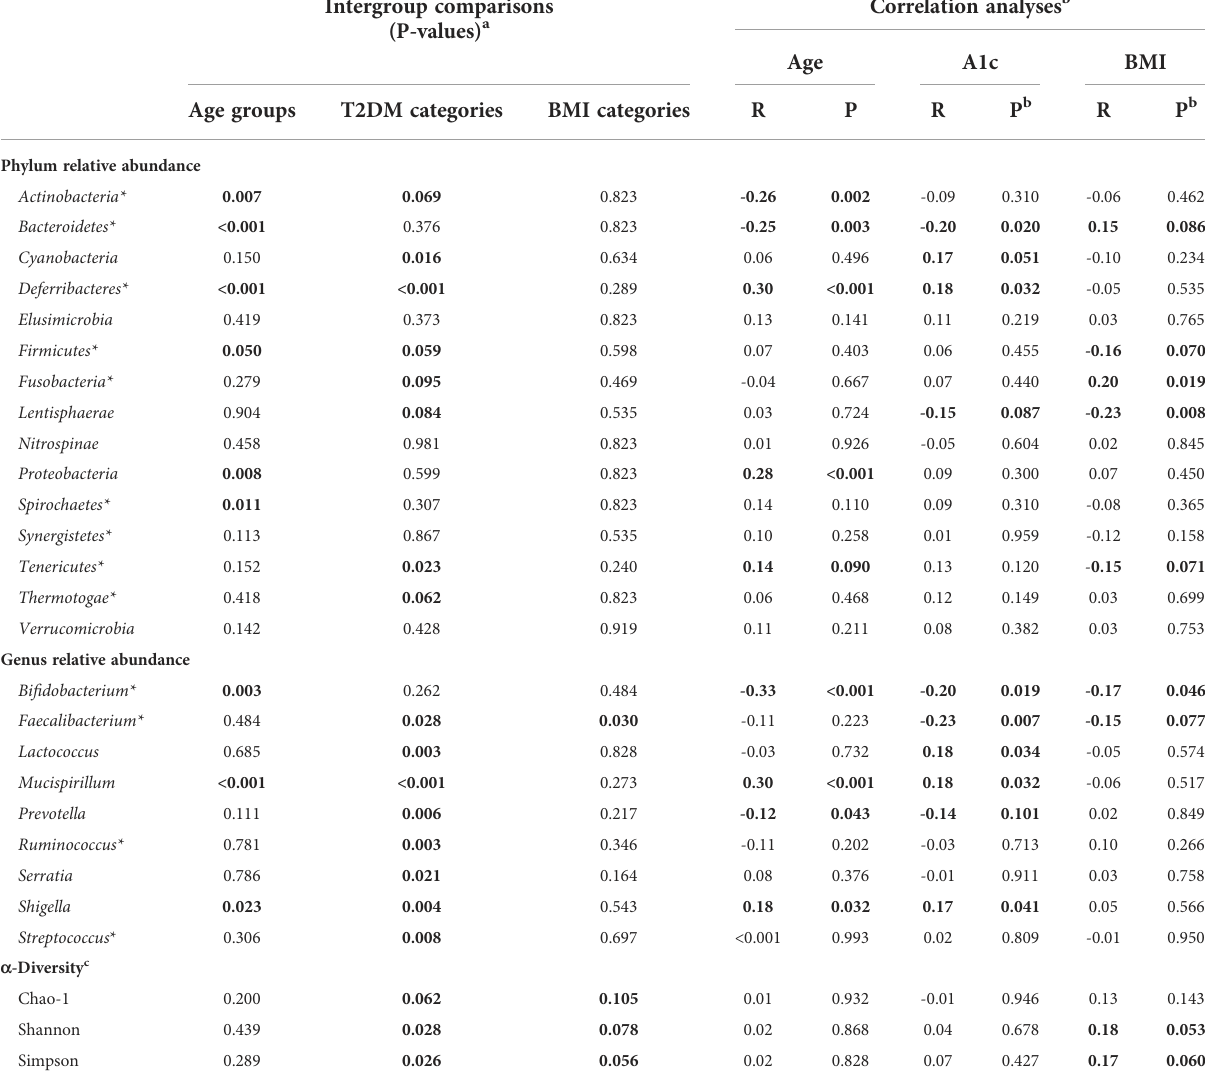
TABLE 2 Intergroup comparisons and correlation analyses for gut bacterial population distribution across age groups, T2DM categories, and BMI categories. Intergroup comparisons (P-values)